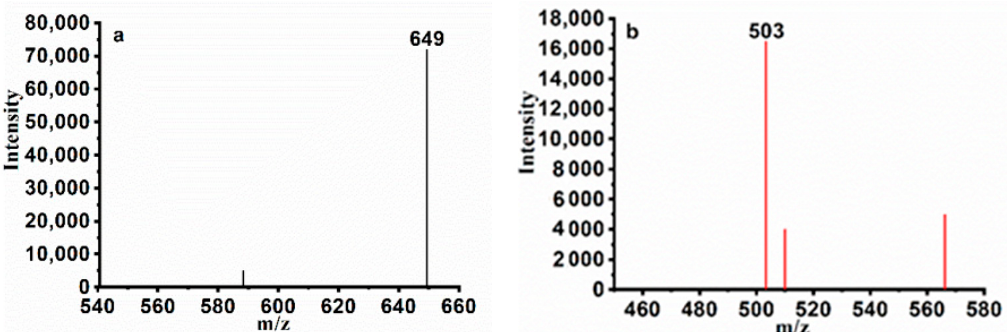
Figure 2. HPLC-MS analysis of the rhamnolipids. LC–MS spectrum of main components (retention times of 10.023 min ( a ) and 12.664min ( b )) of the rhamnolipids. Table 2. The components of rhamnolipid products.